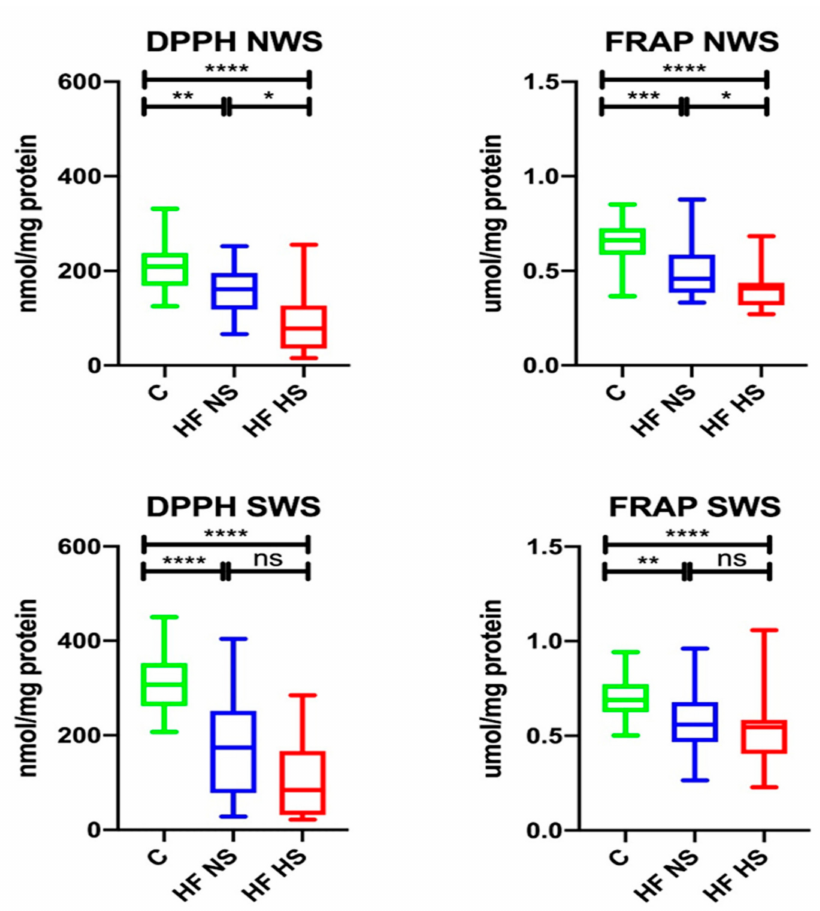
Figure 2. Salivary redox status in non-stimulated and stimulated saliva of HF patients and the control group. Abbreviations: DPPH—2,2-diphenyl-1-picrylhydrazyl radical;